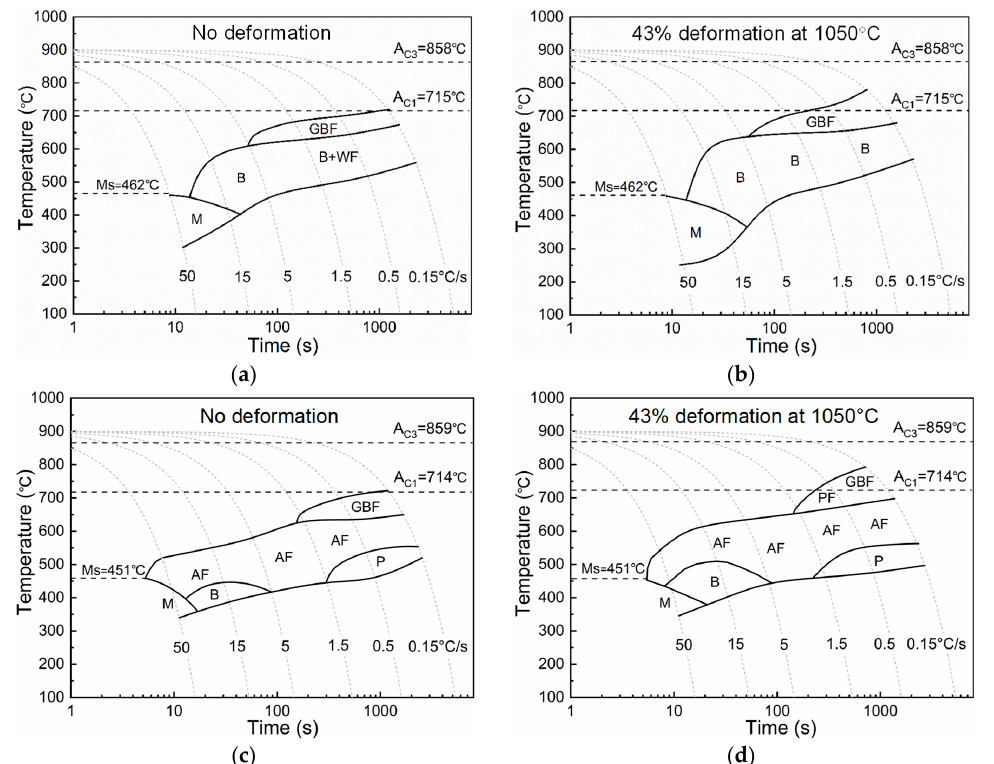
Figure 5. Continuous cooling transformation (CCT) diagrams of ( a, b ) AC# steel and ( c, d ) TC# steel. GBF: Grain boundary ferrite; WF: Widmanstätten ferrite; AF: Acicular ferrite; P: Pearlite; B: Bainite; M: Martensite.